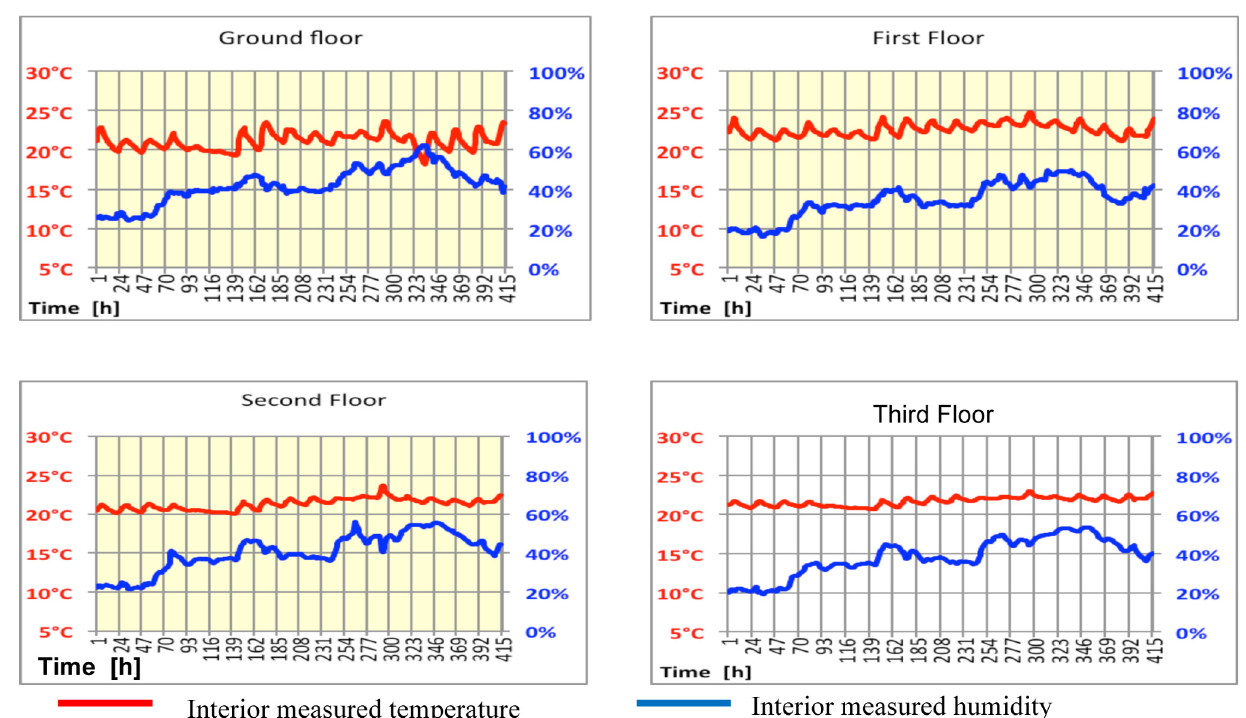
Fig. 8. Interior temperature and humidity